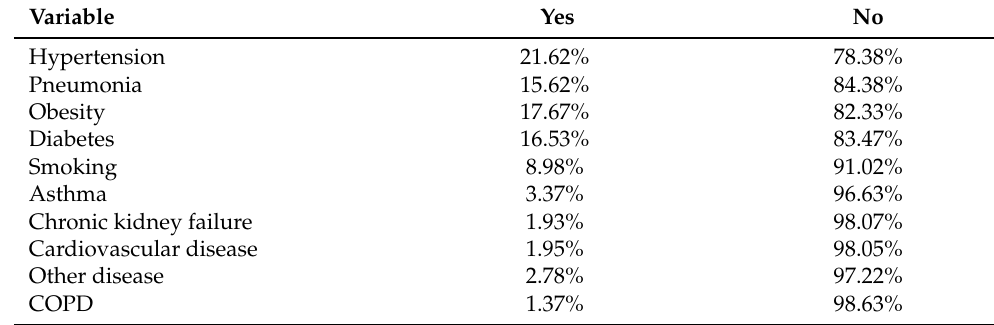
Table 3. Percentage of COVID-19 patients with any comorbidity, out of a total of 3,119,851 observations.